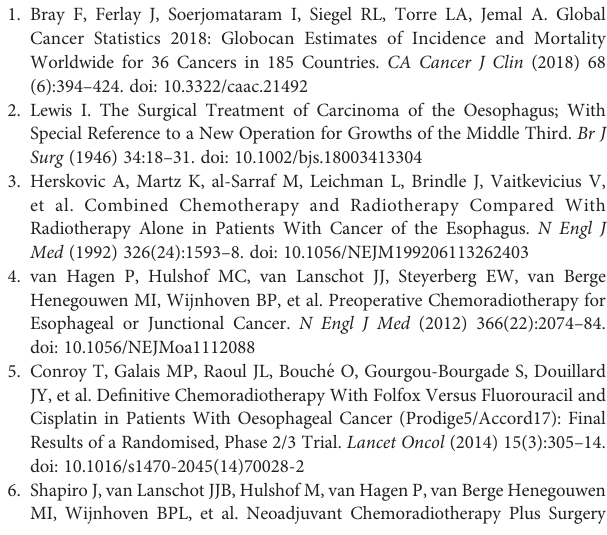
Supplementary Figure 1 | Supraclavicular lymph nodes are analogous to level 4 in head and neck cancers. The cranial border is de fi ned by the cricoid cartilage. The anterior borders correspond to the sternocleidomastoid muscles. Cranially the posterior border is the posterior edge of the sternocleidomastoid muscle. Caudally the posterior border is the anterior edge of the scalene muscles and the apex of the lungs. The medial limit is the medial edge of the common carotid artery. The lateral limit is de fi ned by the lateral edge of the sternocleidomastoid muscle cranially and the lateraledgeof thescalene muscles caudally.Theinferior border extends intothe thoracic inlet. Supplementary Figure 2 | Para-esophageal, paratracheal, pretracheal and mediastinal (anterior mediastinal, retrotracheal, posterior mediastinal and trachea- bronchial) lymph nodes. Above the carina, the CTV will encompass the entire trachea and extend radially to encompass the lower and upper paratracheal nodal stations which correspond to levels 2 and 4 in the IASLC staging atlas. Above the aortic arch the anterior border of the CTV is de fi ned by the sternum and clavicular heads to encompass prevascular nodes (IASLC level 3). Above the level of the thoracic inlet, the trachea should be excluded from the CTV (unless the 1cm radial margin to the esophagus requires it). For distal tumors in which the CTV extends superiorly to the mediastinum only to respect the cranial margin to the primary tumor or to para-esophageal lymph node metastases, the superior nodal stations except for the para- esophageal lymph nodes need not to be included. Supplementary Figure 3 | Paraaortic, hepatogastric ligament, celiac lymph nodes. Below the diaphragm the CTV should be extended inferiorly to the level of the origin of the celiac axis. The CTV will be bounded in the lateral aspect by the vertebral body on the right (usually Th12) and 0.5-1 cm beyond the lateral aspect of the aorta on the left, the vertebral body posteriorly and the pancreatic body anteriorly.Betweenthelevelofthegastro-esophagealjunctionandtheceliaclymph nodes the lesser curvature nodes will be included. In this region the liver will de fi ne the right border and the stomach will de fi ne the left border. Anteriorly the CTV includes the fatty space between the lesser curvature and the